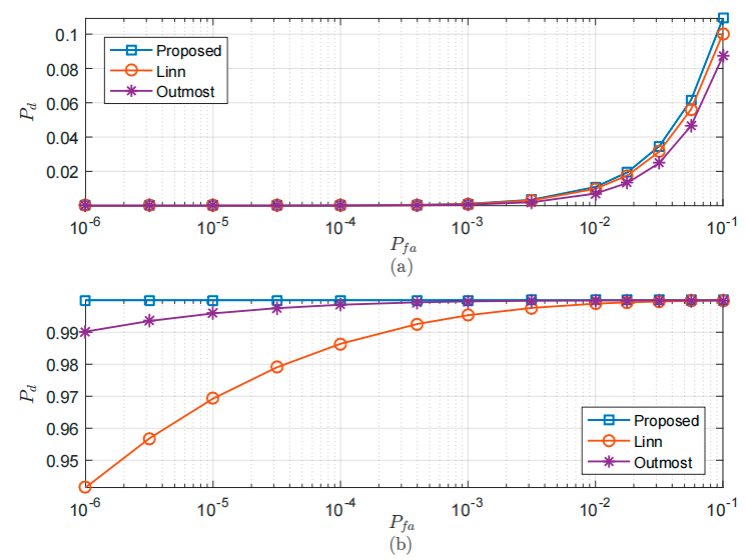
Figure 8. ROC curves of the 16APSK signal carrier synchronization lock detector at two different SNRs: ( a ) E s / N 0 = 6.2706dB ( b ) E s / N 0 = 11.2706dB.